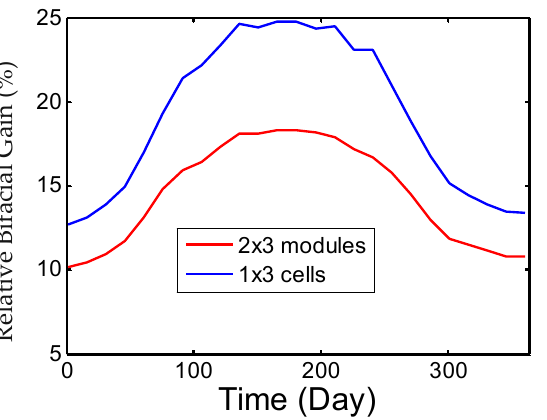
Figure 8. Modelled relative bifacial gain over the course of the year for a minimodule (blue) and a string of six modules (red).